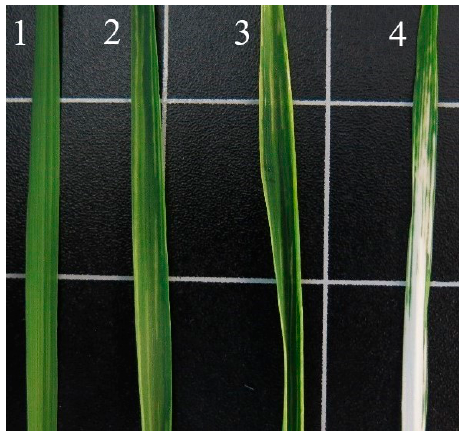
Figure 2. Wheat leaves infected with virus constructs. 10–12 dpi. 1—negative control, 2—empty vector, 3—BSMV-TRI5, 4—BSMV-PDS.